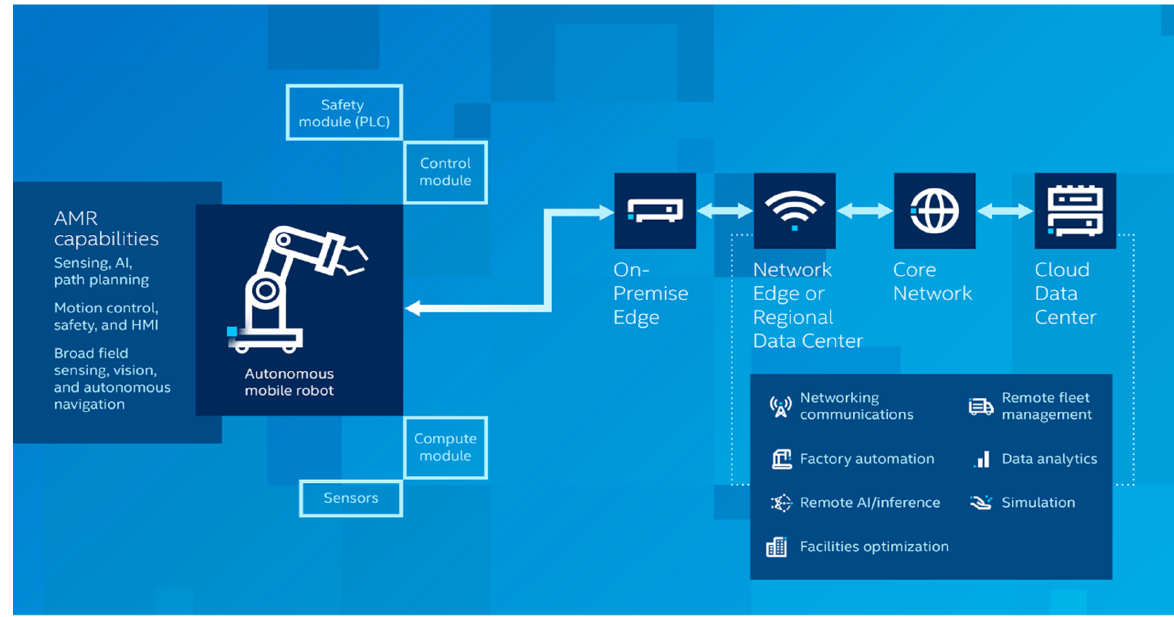
Figure 12. A complete list of components and architecture of modern intelligent mobile robots